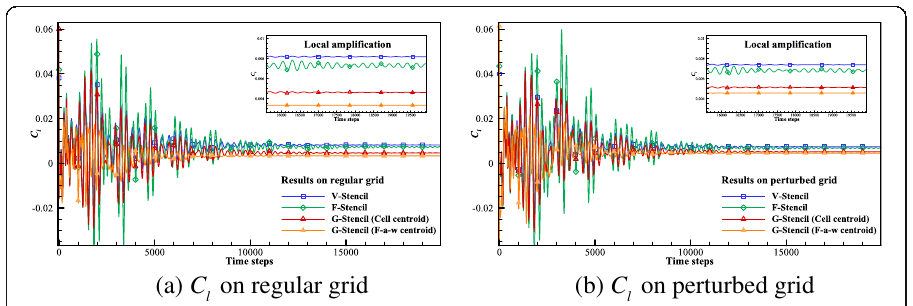
Fig. 26 C l on ( a ) regular and ( b ) perturbed triangular